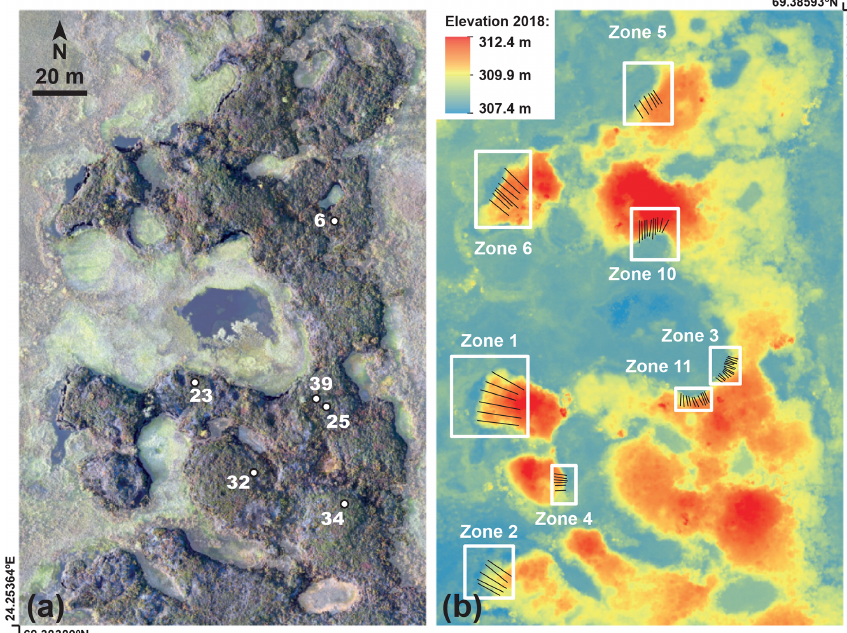
Figure 2. (a) Orthophoto of the peat plateau (transparent white shading applied to the mire to better distinguish it from the plateau). The white dots indicate the location of snow measurements presented in Fig. 3. (b) Digital elevation model of the plateau in 2018. The edge transect areas on which this study focuses are indicated by white boxes. The black lines indicate the profiles used to derive the edge retreat metric described in Sect. 3.2.